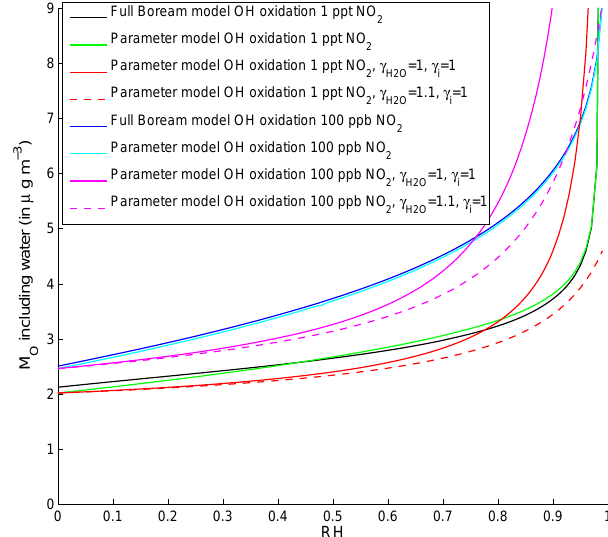
Fig. 15. The impact of relative humidity (RH) on total absorbing mass M O (including water), for the full model in the case of OH- oxidation at low-NO x (black) and high-NO x (blue), at 288K. Note that the applied α -pinene concentration was higher in the case of the high-NO x simulation shown here. The parameter model results are given in green for low NO x and cyan for high NO x . Two sensi- tivity tests illustrate the model discrepancy resulting from the use of constant values for the activity coefficients in the parameter